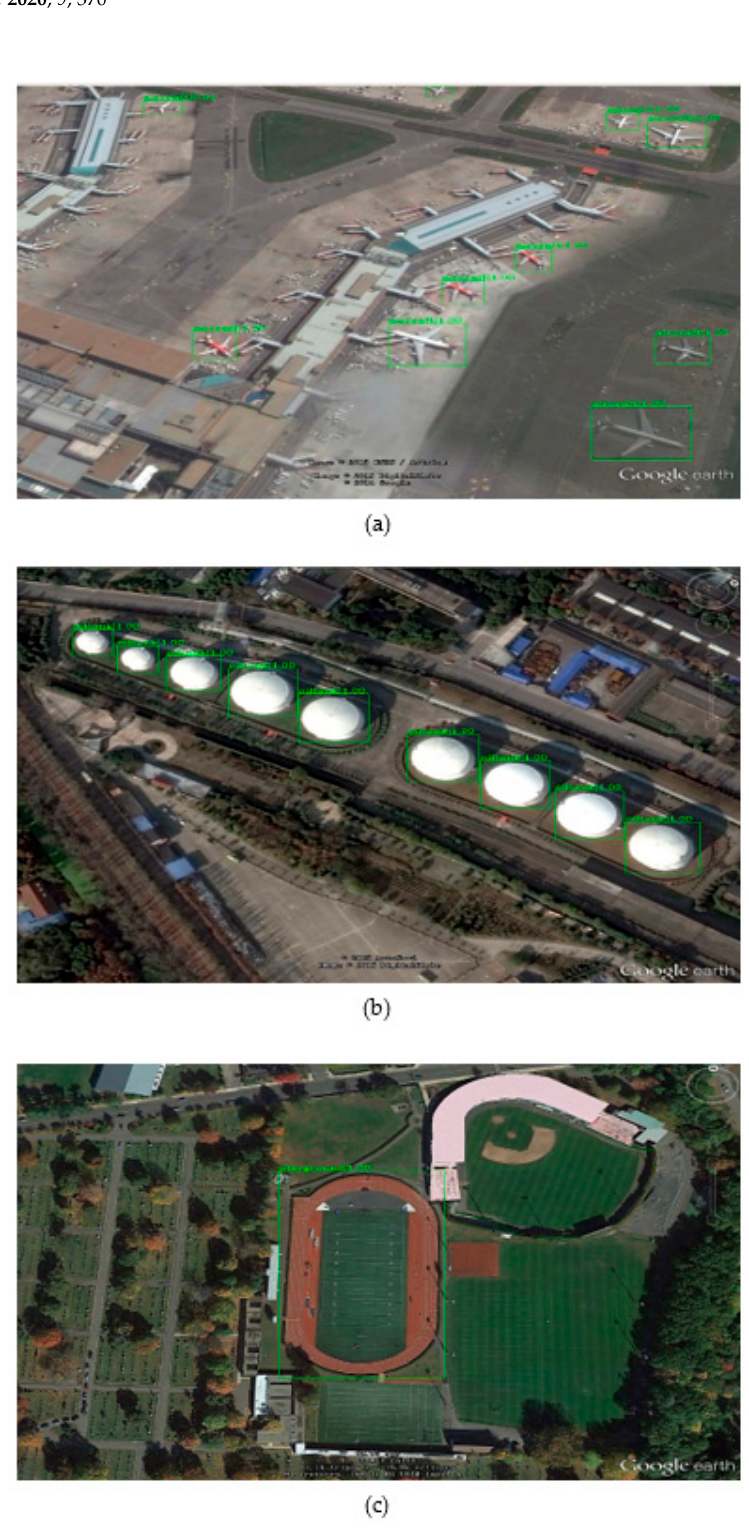
Figure A2. Object detection examples on an RSOD dataset: ( a ) aircraft; ( b ) oil tank; ( c ) playground.